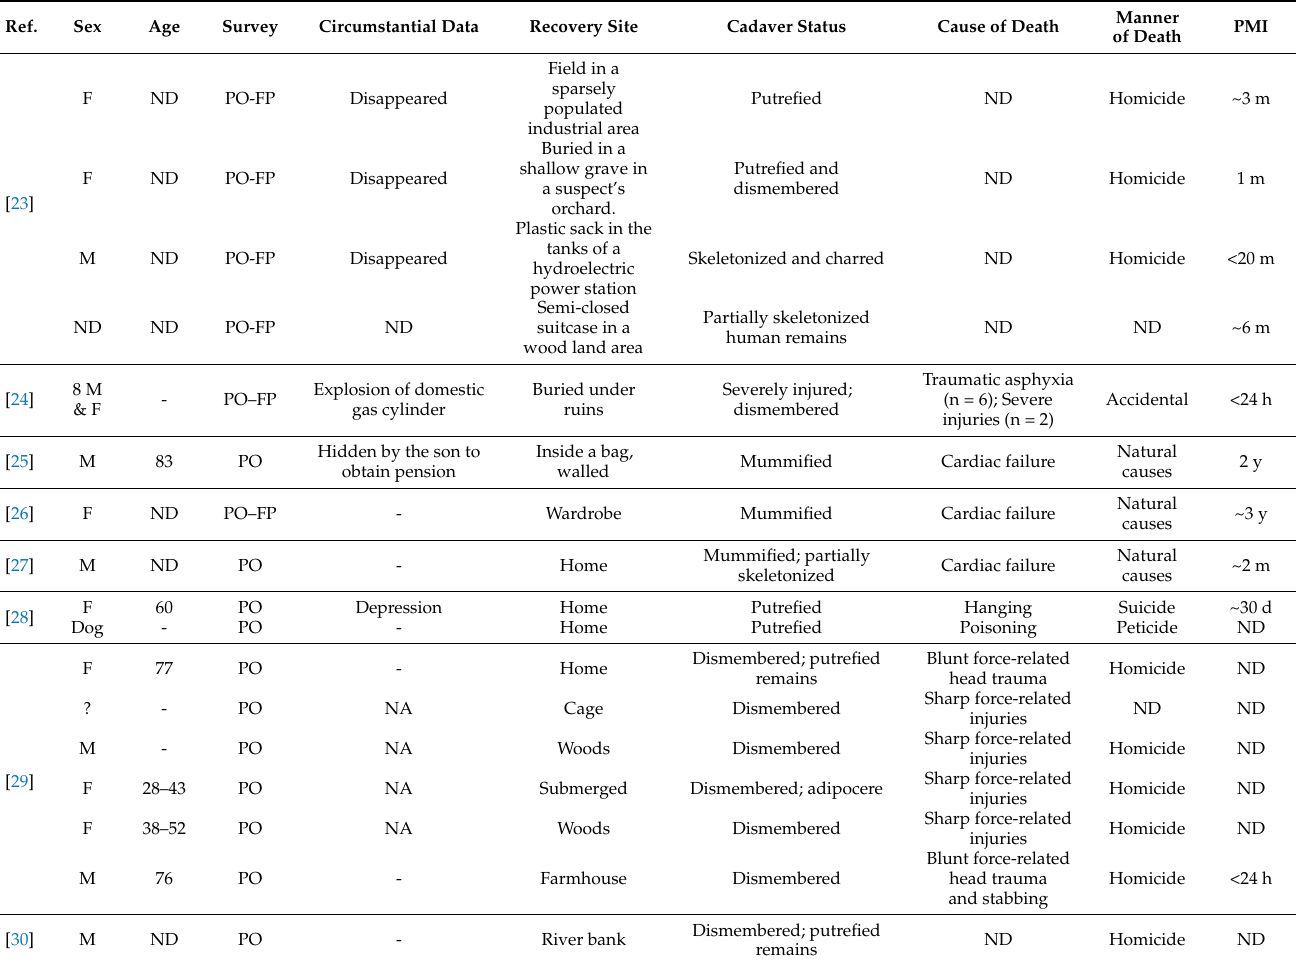
Table 3. Schematic representation of the investigations performed in each case reported in the